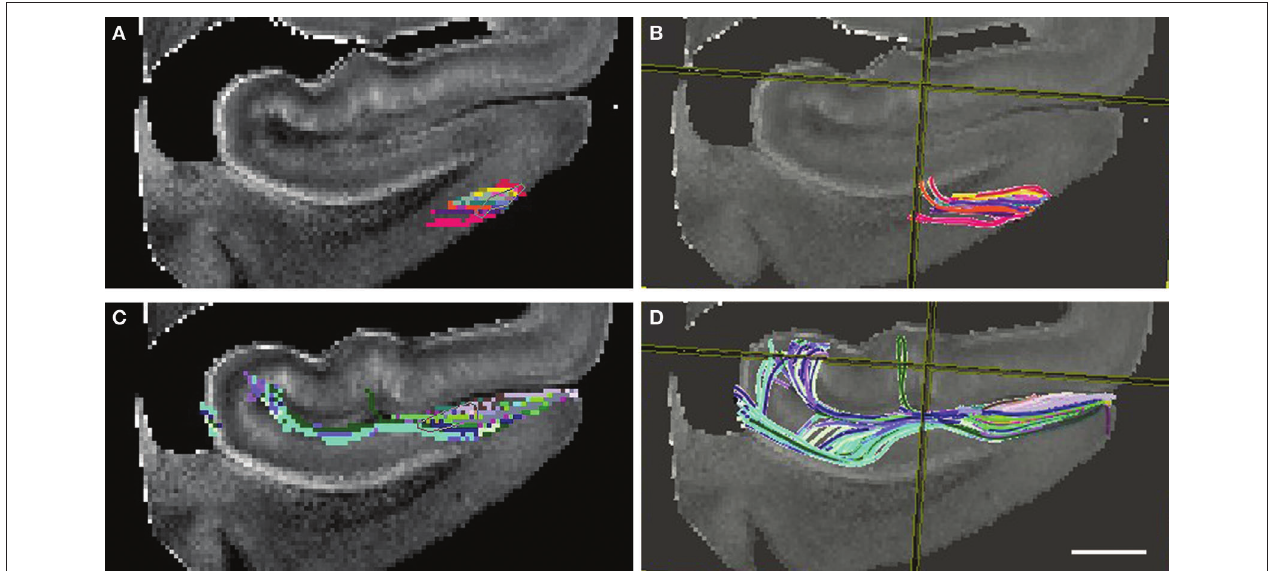
bundle (B) and perforant pathway streamline shows an indication of crossing the hippocampal fissure and the temporoalvear pathway coursing around the hippocampal fissure (D) . Magnification bar = 0.25